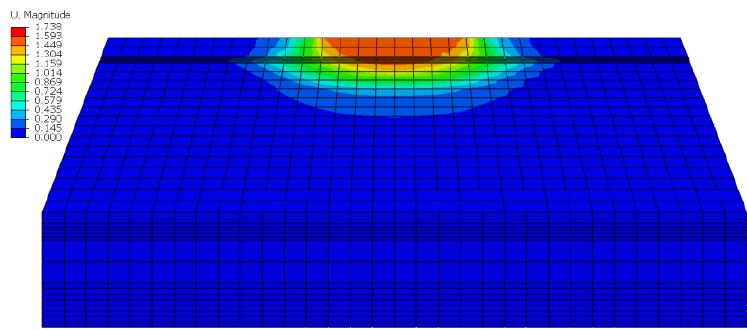
Figure 6. Displacement cloud map of soil mass.